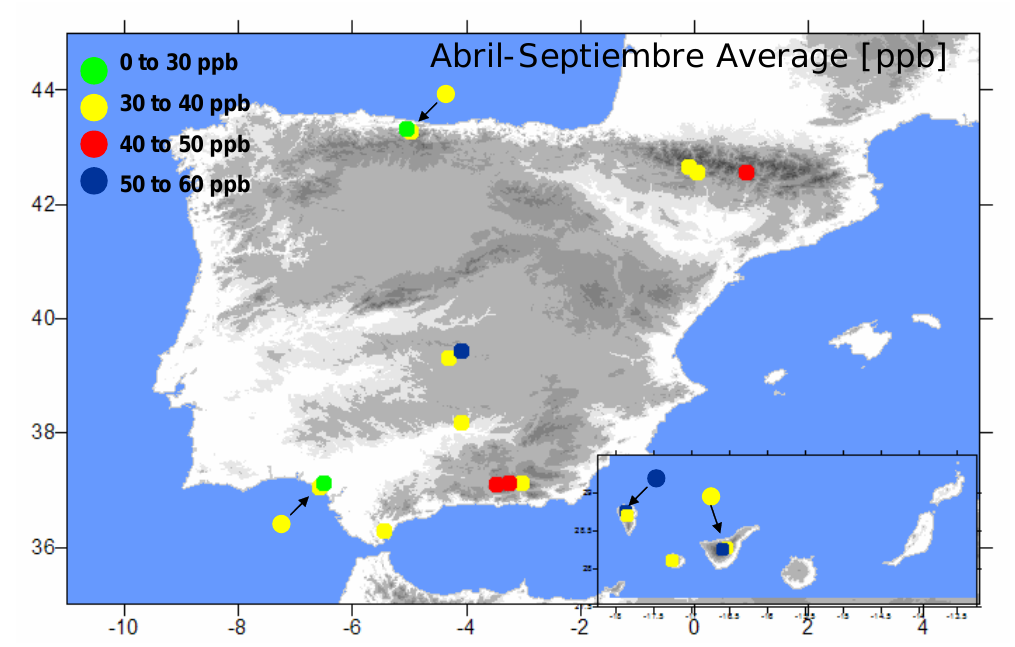
FIGURE 4 . Maps with ozone seasonal (April–September) averages for 2002